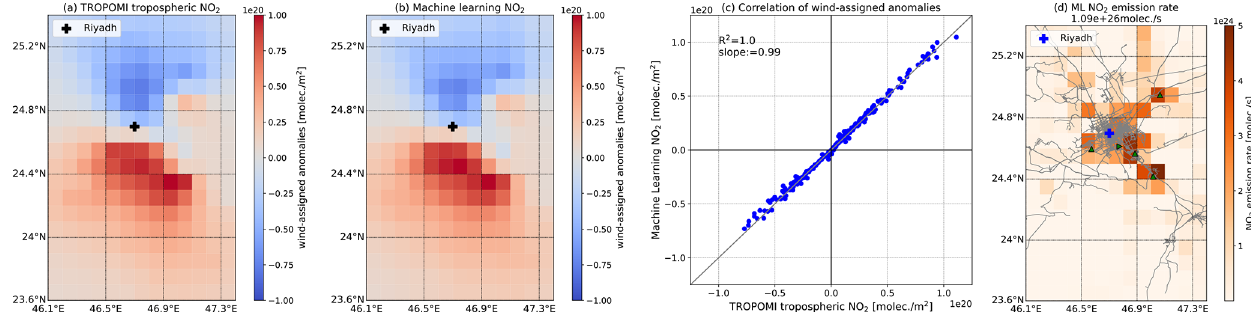
Figure 1. Wind-assigned plumes derived from (a) TROPOMI tropospheric NO 2 and (b) the ML method; (c) a correlation plot between (a) and (b) for each grid (where the x and y labels represent the data sets from which the wind-assigned anomalies were derived); and (d) the estimated emission rates in Riyadh, Saudi Arabia. The data in panels (a) , (b) , and (d) are gridded on a regular latitude–longitude grid with 0.1 ◦ spacing. In panel (d) , the number in the panel heading presents the total emission rate; triangle symbols and the right-pointing triangle symbol represent power plants and a cement plant, respectively; gray lines represent the highways (data derived from https://www.openstreetmap.org (last access: 19 April 2023), © OpenStreetMap, and https://www.mapcruzin.com, last access: 11 April